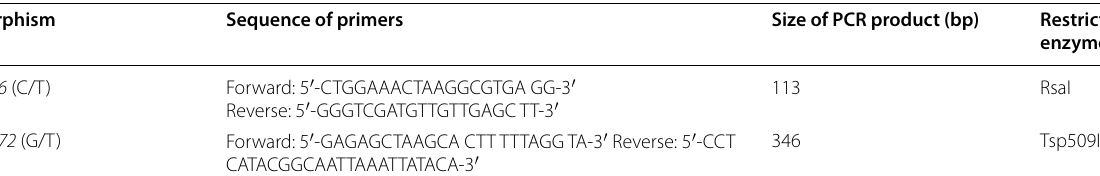
(Finzyme, Finland), and 500 ng DNA. Thermal cycling